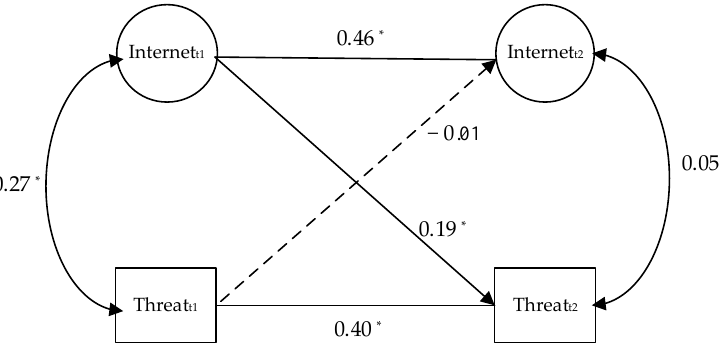
Figure 2. Result of the cross-lagged analyses of the relationship between internet/social media intensity and the perceived threat of COVID-19. Note. Internet = internet/social media intensity; Threat = the perceived threat of COVID-19; t1 = wave 1, t2 = wave 2. * p <